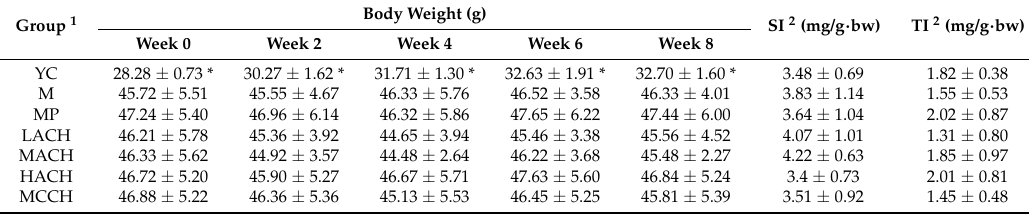
Table 3. Body weight, spleen index (SI) and thymus index (TI) of mice.